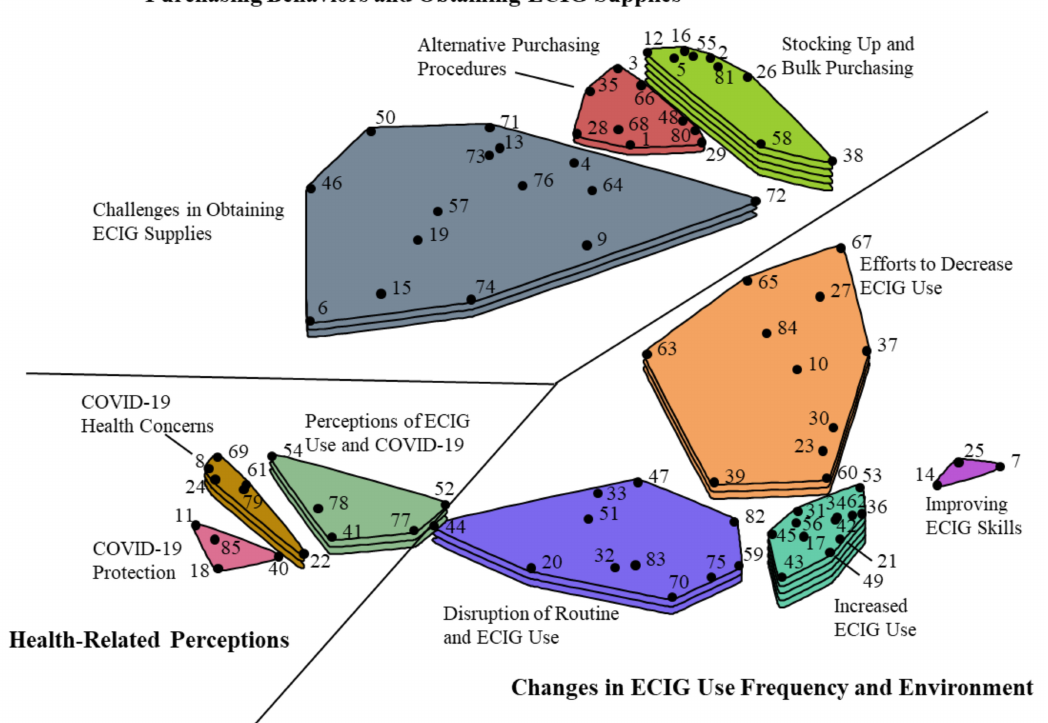
Figure 1. Concept map displaying 10 clusters ECIG user-identified statements describing the impacts of COVID-19 on vaping. Numbered points on the map that are closer to one another represent statements of more similar content whereas points on the map that are further apart represent statements of less similar content. Greater number of layers in clusters indicate higher mean ratings of statements within each cluster based on the rating task. Mean ratings for clusters with 1 layer range from 2.84 to 3.10, 2 layers from 3.10 to 3.36, 3 layers from 3.36 to 3.61, 4 layers from 3.61 to 3.87, and 5 layers from 3.87 to